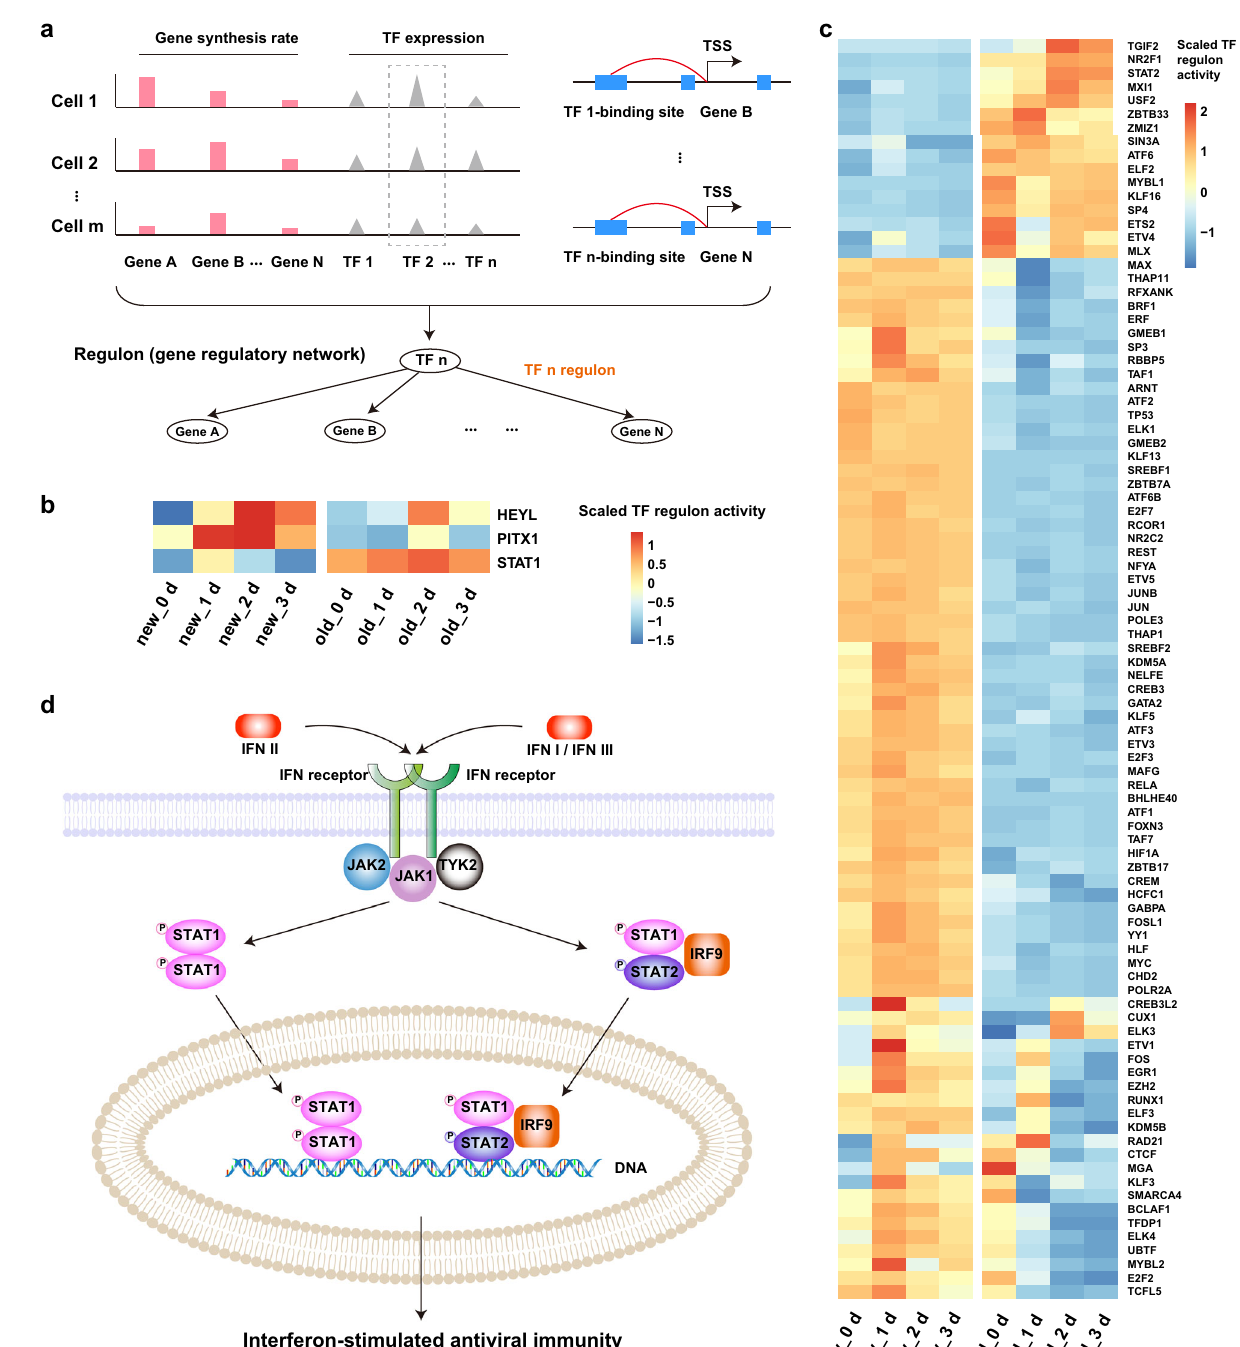
Fig. 4 | Analysis of treatment-dependent regulon activity of HCT116 cells in response to 5-AZA-CdR. a Schematic illustration of regulon identi fi cation by linking TFs with their regulating genes. b Heat map showing average regulon activity of 3 5-AZA-CdR treatment-dependent regulons of HCT116 cells, inferred from either new or old RNAs. Regulons with signi fi cantly increased or decreased activities(absolute foldchange>1.5)wereidenti fi ed by atwo-sided Wilcoxonrank-